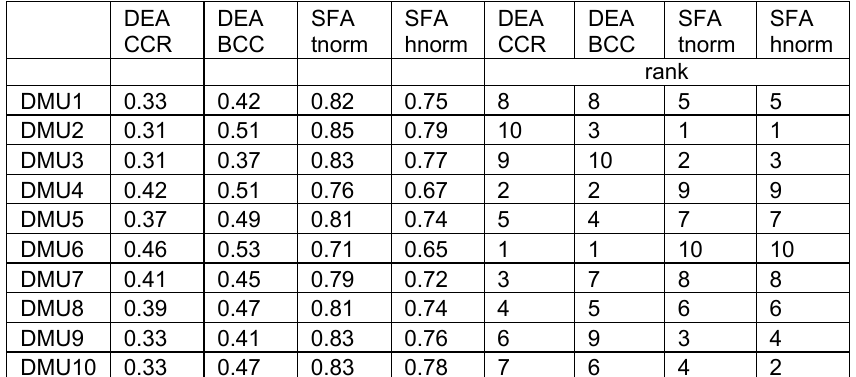
Table 5 – Average efficiency of vehicles by transport units Таблица 5 – Средняя эффективность транспортных средств по транспортным